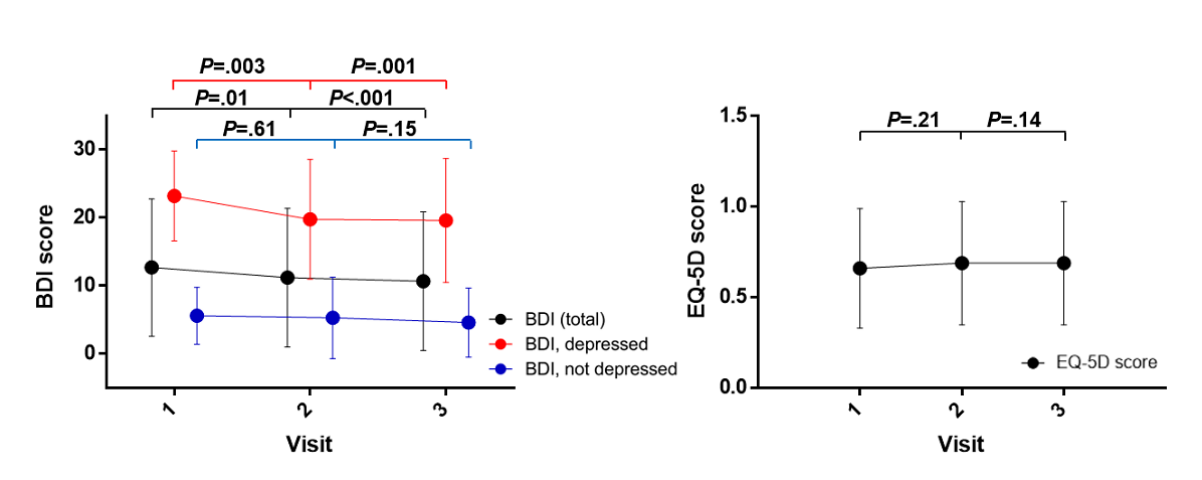
Figure 6. Trends of the Beck Depression Inventory-II (BDI) score in patients who were depressed and not depressed (left) and of the EuroQol-5 Dimensions (EQ-5D) score